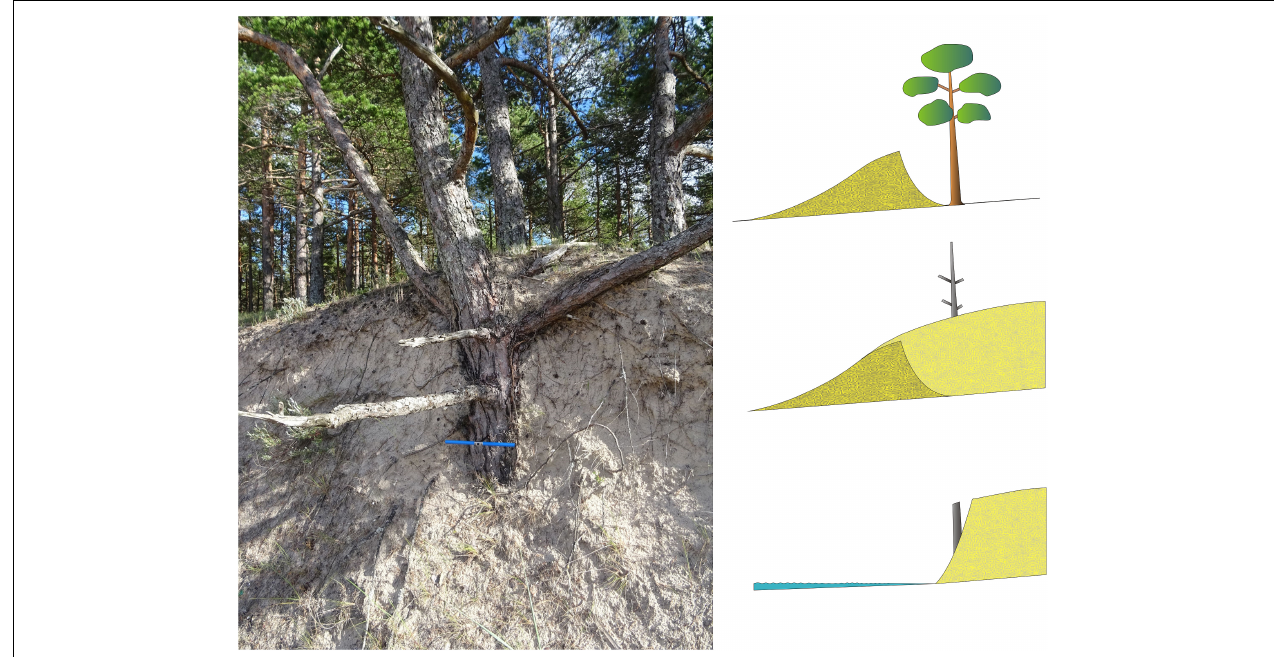
FIGURE 7 | Trunk of a surviving pine partially re-exposed at the coast between Mazirbe and Kolka (stretch 6) as a result of coastal bluff erosion after burial by sand (photograph). Burial of the lower part of a pine trunk and subsequent re-exposure of its stump